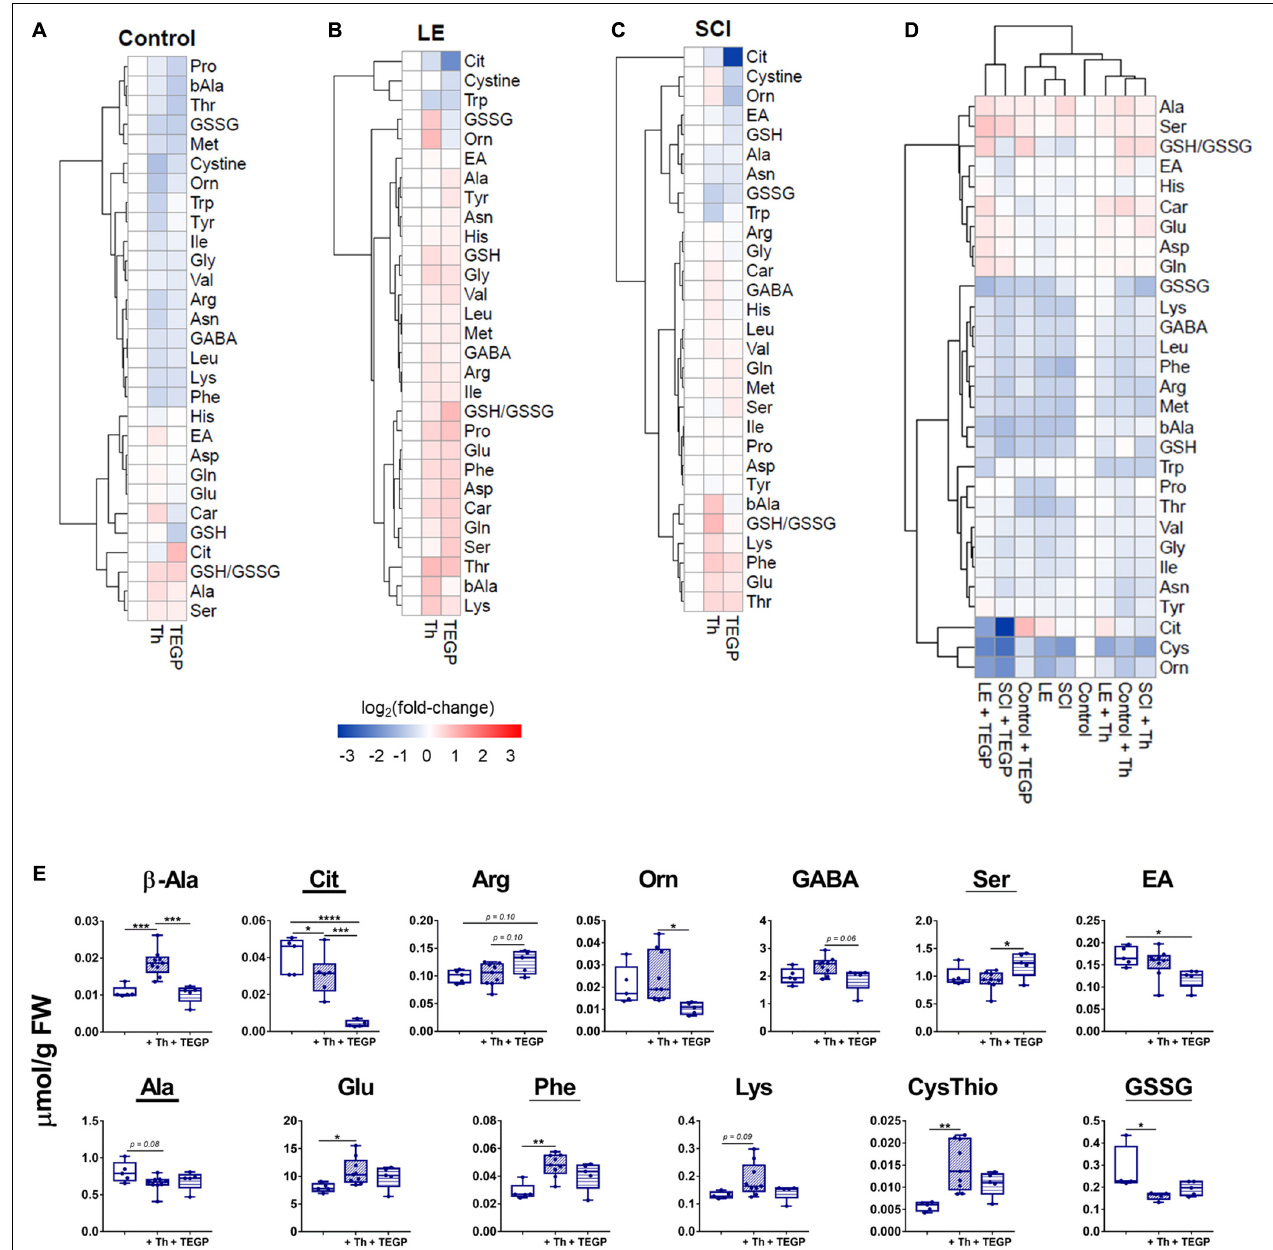
FIGURE 7 | Physiological-state-dependent effects of the OGDHC regulators thiamine and TEGP on the metabolic profiles of cerebral cortex of the control and operated rats. (A) Non-operated rats (Control); (B) rats subjected to LE; (C) rats subjected to SCI; (D) all groups; (E) metabolic markers, discriminating the action of thiamine and/or TEGP in SCI animals. Statistically significance of the changes is determined by one-way ANOVA followed by post hoc Tukey’s test. Underlined are the metabolites changed in SCI vs. LE animals, according to Table 1 . Metabolites are abbreviated as in Table 1 . Clustering of metabolites and heatmaps in (A–C) are created using ward.D2 and pheatmap package in RStudio. The data in (A–C) are presented as log 2 (fold-change), where fold-change is a proportion of the mean metabolite level in the thiamine (Th) or TEGP-treated groups to the corresponding mean in the reference group. The color code of the fold-changes is defined by the scale bar under the heatmaps (A–C) . On the graphs, different p -values are shown by asterisks as described in Methods under Statistical Analysis. Number of animals in each group: LE, n = 5; SCI, n = 5; LE + Th, n ≥ 6; SCI + Th, n ≥ 5, LE + TEGP, n = 6; SCI + TEGP, n =